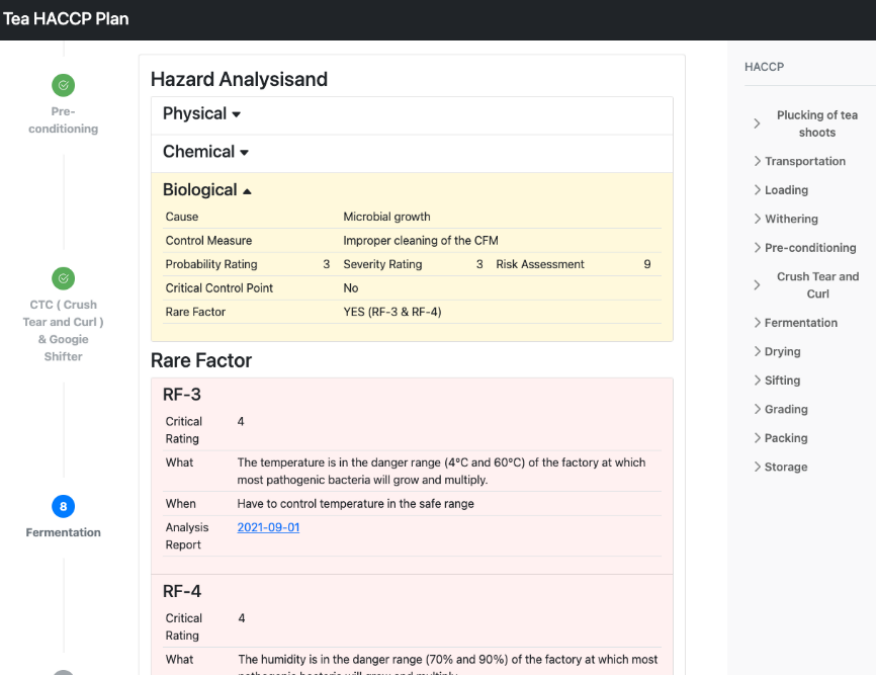
Figure 16. The system implementation of rare factors.